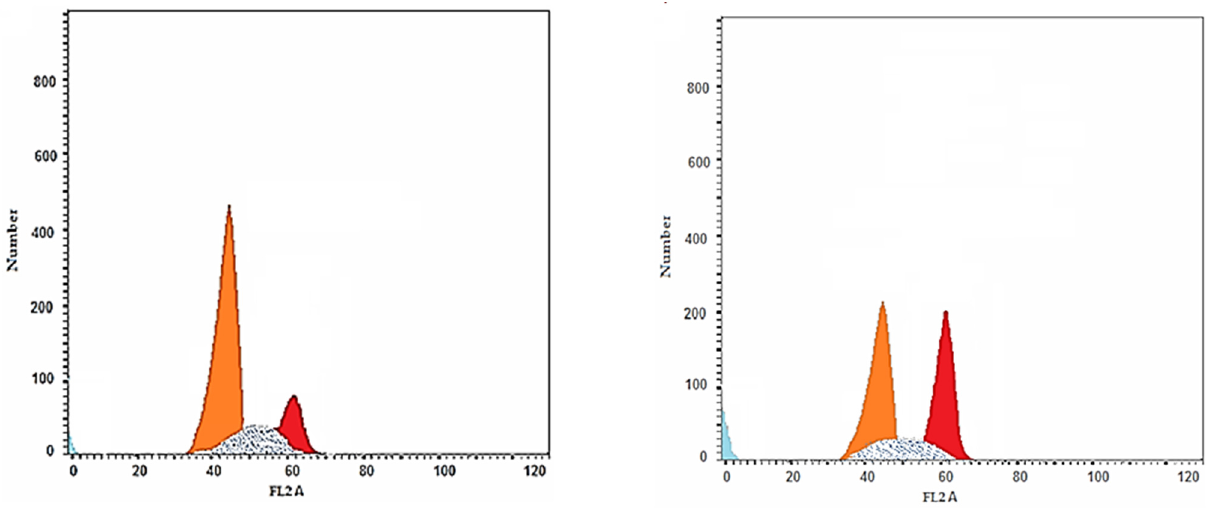
Figure 3. The cell cycle in HCT-116 after treatment with compound 6 employing the flow cytometry. ( a ) is the control test, ( b ) is the treated cells. Compound 6 caused a significant increase of the cells population at the pre-G1 phase (16.93%) in comparison to the control cells (3.05%).